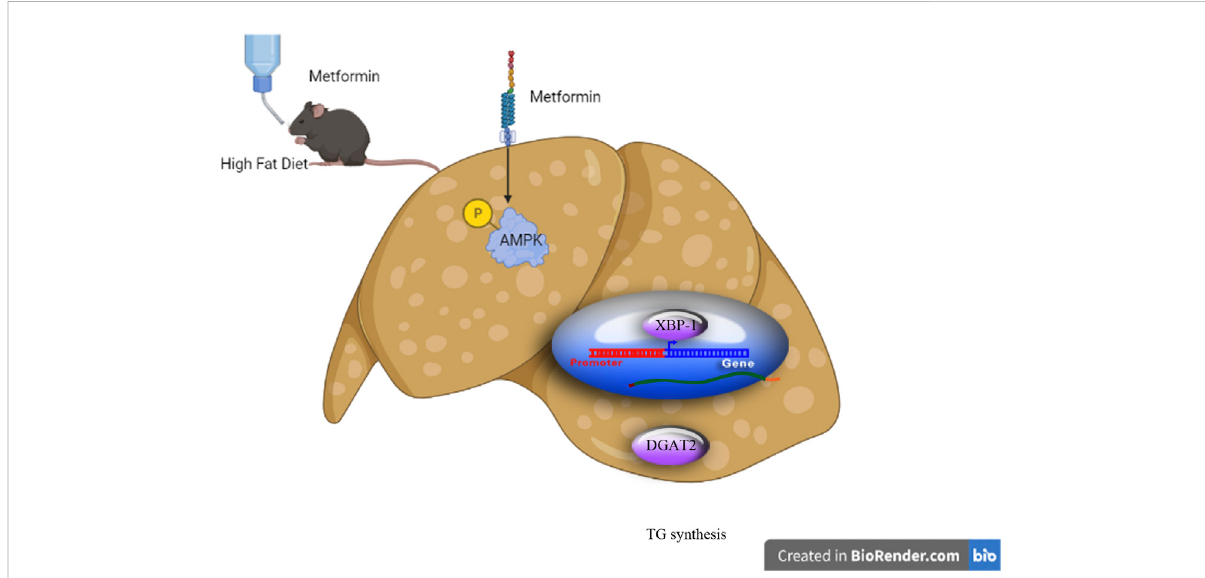
FIGURE 6 Schematic diagram of the experimental protocol and proposed mechanism for the triglyceride-lowering effect of metformin. (Schematic diagram created using